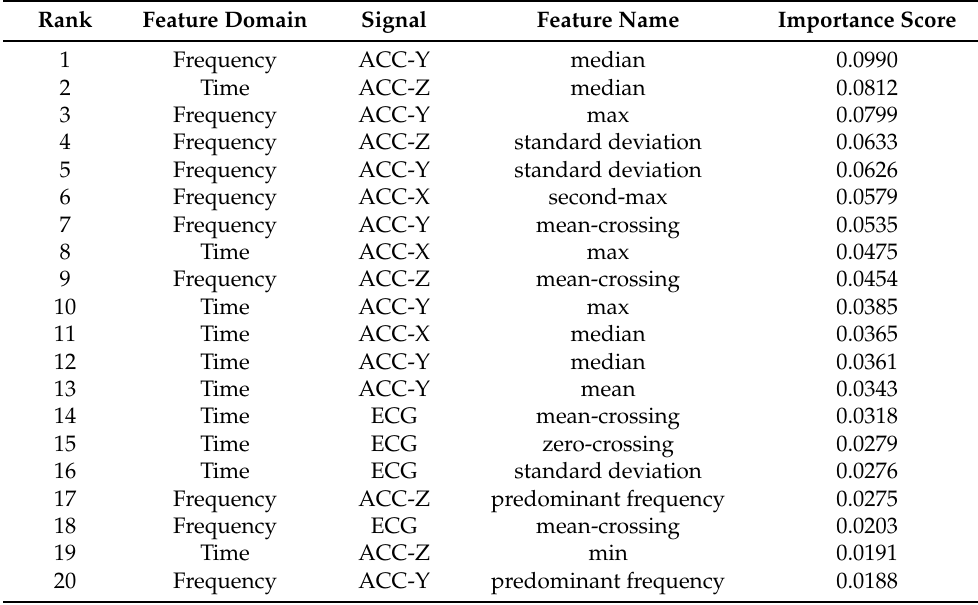
Table 5. Feature importance for 3D-ACC + ECG model (scenario 4) in the cross-subject